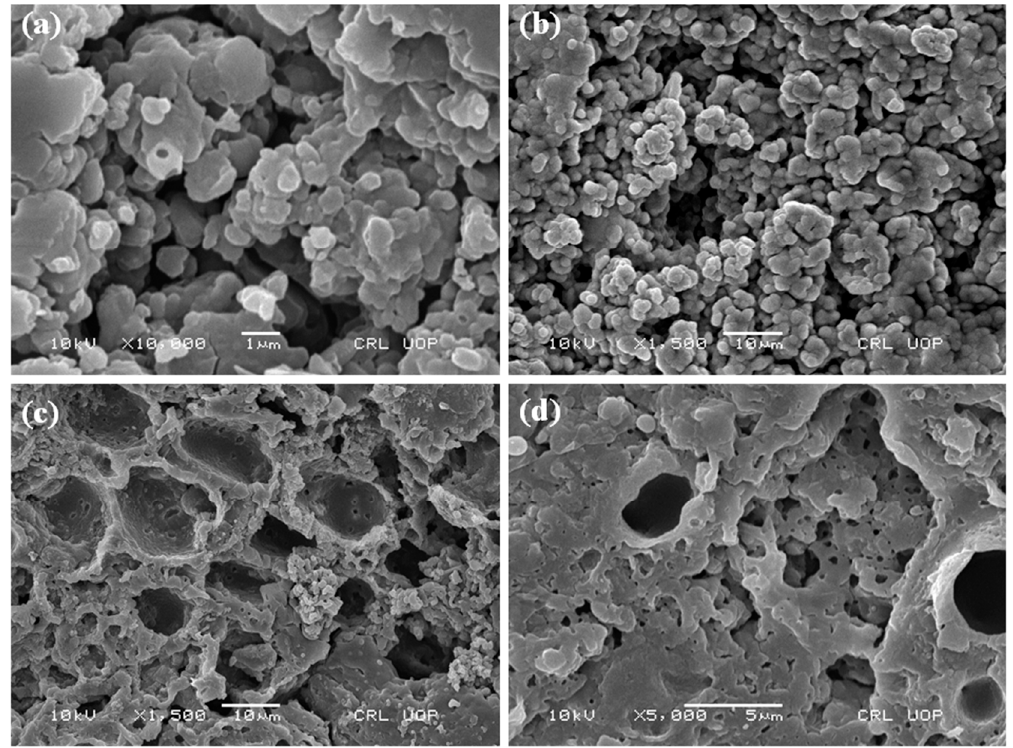
Figure 14. Scanning electron micrograph ( a ) PANI A4 ( b ) PANI B9 ( c ) PANI D2 ( d ) and PANI S3.